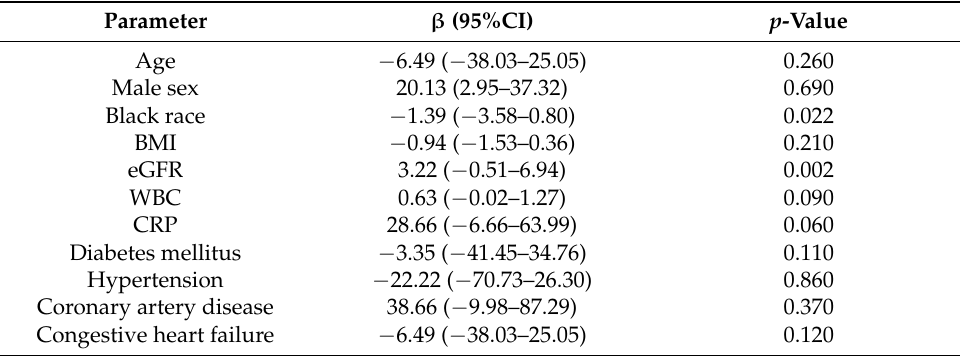
Figure 1. OPN levels in COVID-19 patients and healthy controls. Circulating OPN levels are significantly elevated in COVID-19 upon admission to the hospital compared to healthy controls. Table 2. Determinants of OPN (linear regression model).